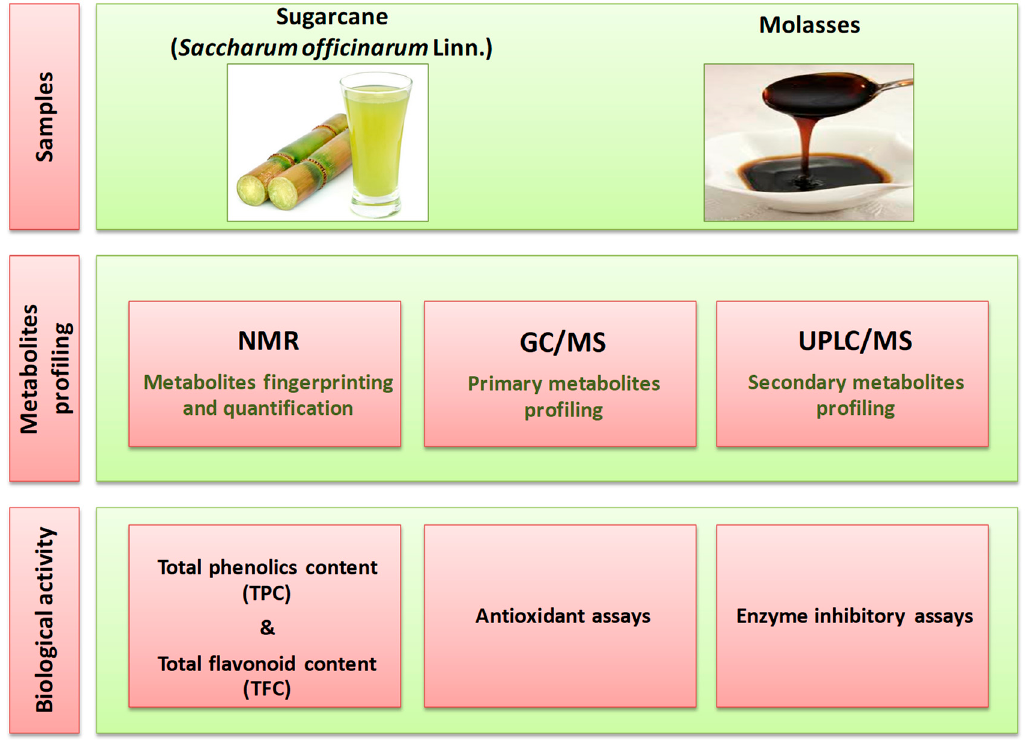
Figure 1. Schematic diagram for study experimental design.